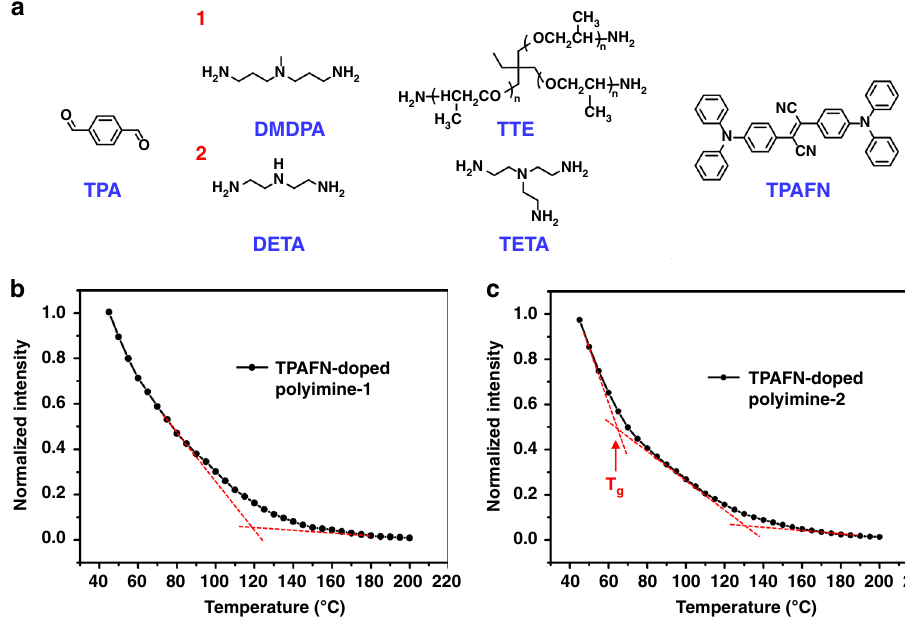
Fig. 5 Detecting T v of polyimines by AIE-probe technique. a Synthesis of polyimine-1 and polyimine-2. b The fl uorescence intensity plot of 0.5 wt% TPAFN- doped polyimine-1 at a series of temperature at 621 nm (Excitation: 527 nm). All the fl uorescence intensities are normalized to 45 °C. c The fl uorescence intensity plot of 0.5 wt% TPAFN-doped polyimine-2 at a series of temperature at 644 nm (Excitation: 527 nm). All the fl uorescence intensities are normalized to 45 °C. The point at about 63 °C is T ether (TTE) (Fig. 5a), according to the method of Zhang and co- workers 6 . As the blank polyimine-1 emits weak brown light (Supplementary Fig. 9a), we doped TPAFN (0.5 wt%) as AIE probes